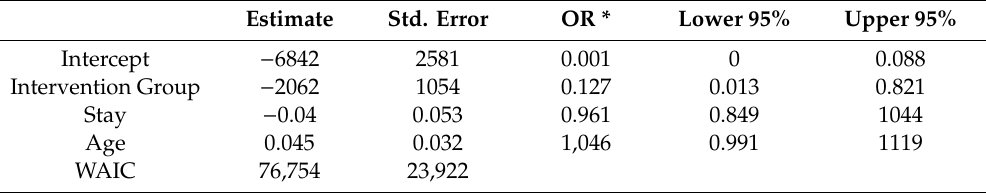
Table 3. Results of the logistic regression model.